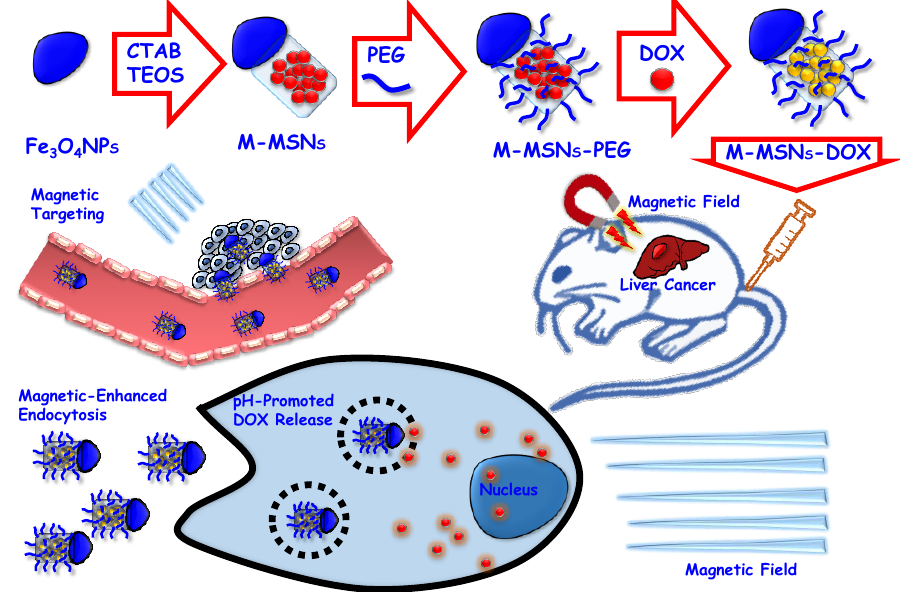
Figure 5. Janus -nanobullets employed for magnetic-targeted drug delivery.